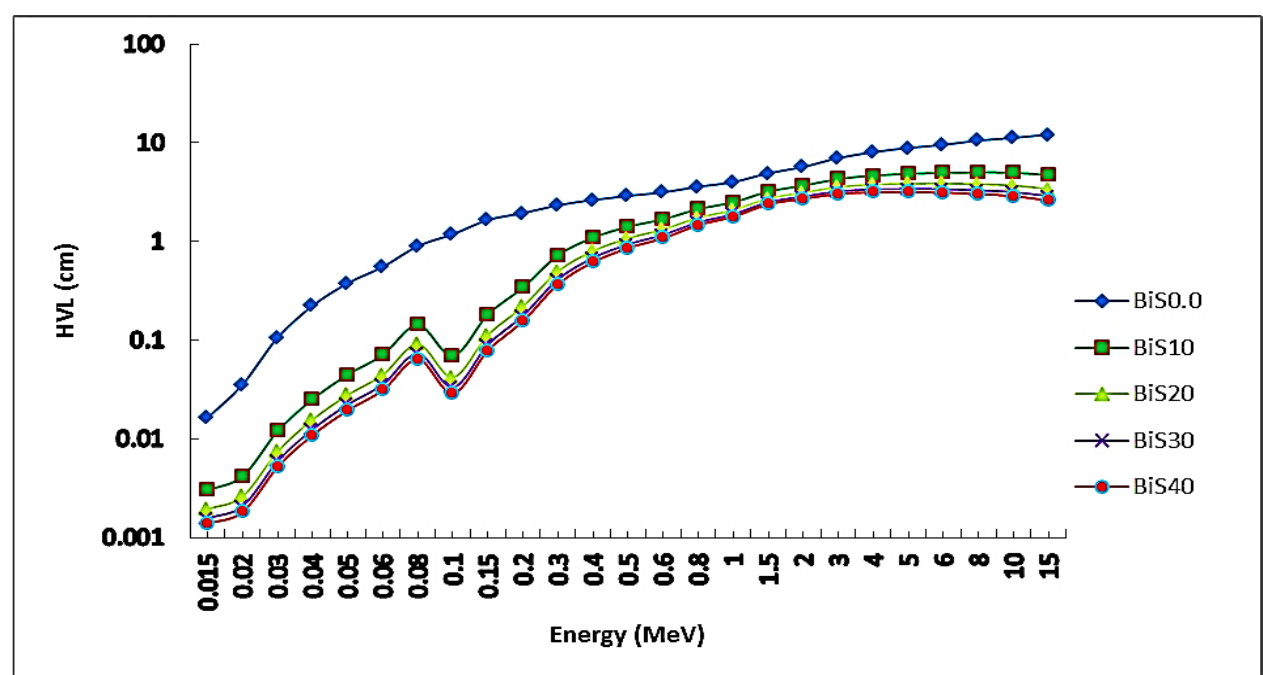
Figure 8. HVL depending on photon energy for all present glass samples.